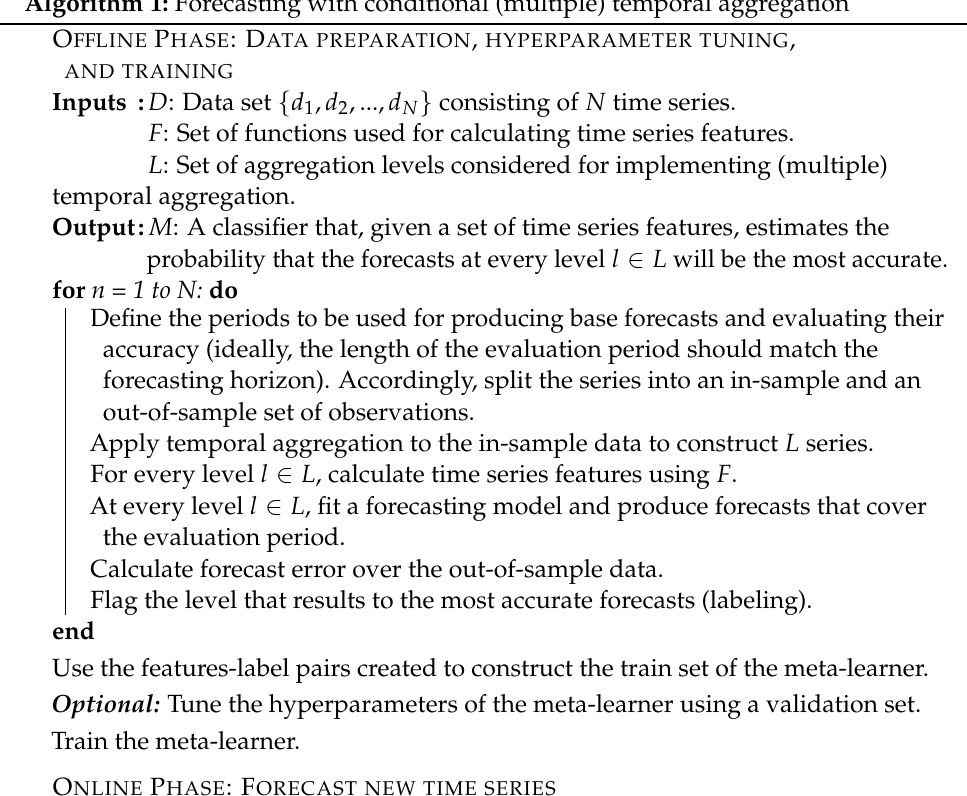
Algorithm 1: Forecasting with conditional (multiple) temporal